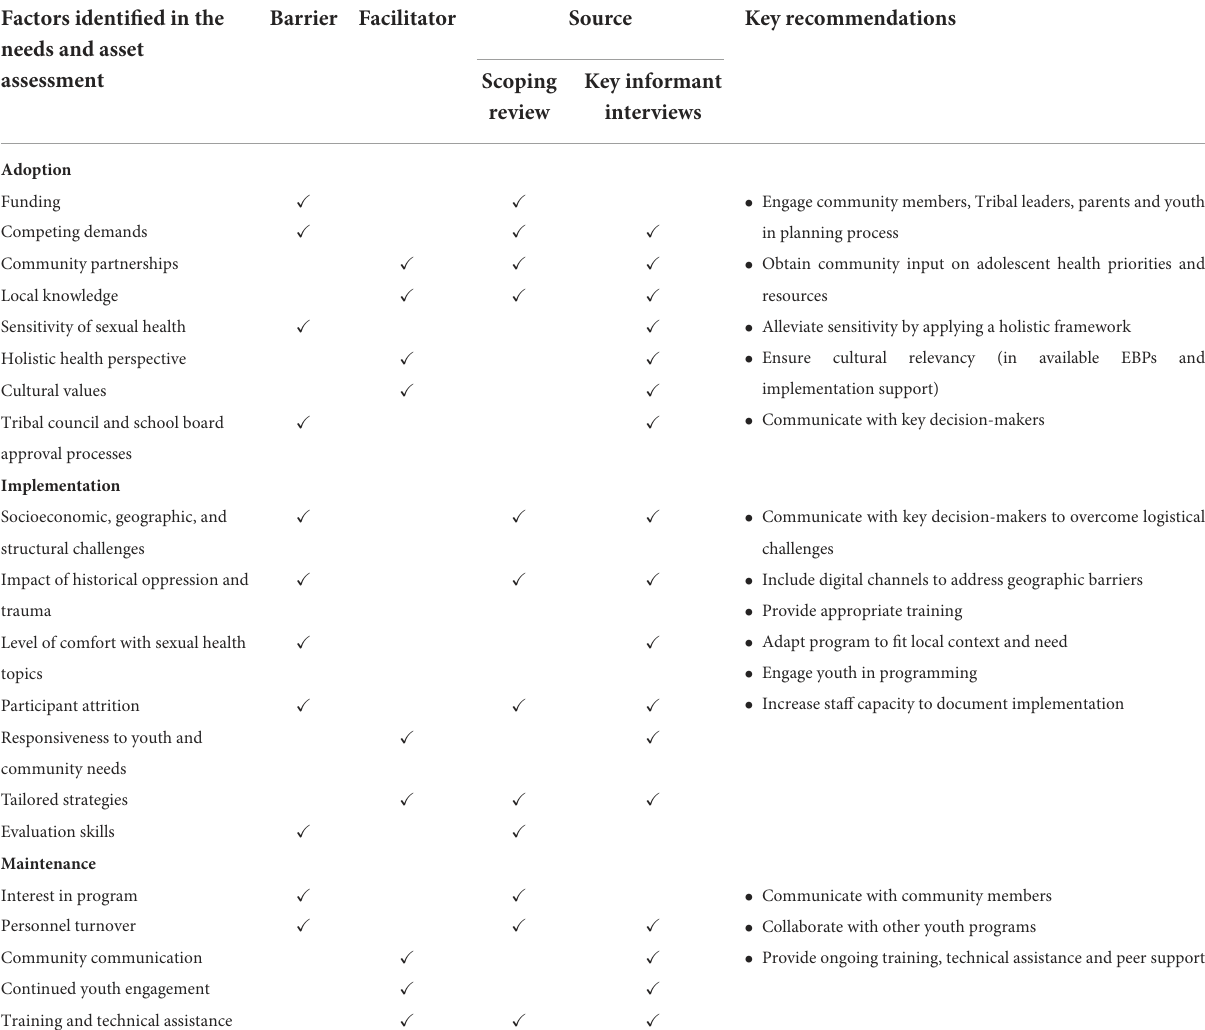
TABLE 1 Implementation Mapping Task 1: Identified barriers and facilitators for adopting, implementing, and maintaining culturally-relevant, evidence-based sexual health education programs in AI/AN communities. Factors identified in the needs and